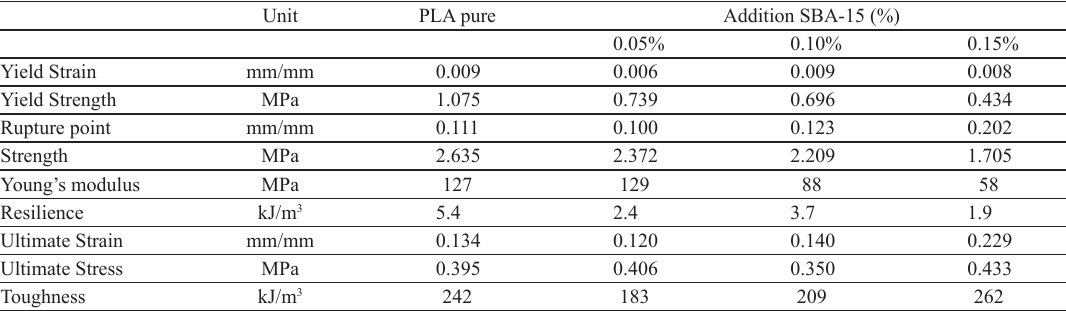
Figure 9. Mechanical properties of the PLA fiber spun mat of 10% and PLA/SBA‑15 fiber composite. (A) Represent the Yield strength, (B) the strength, (C) the resilience, (D) the Young´s Modulus, (E) the rupture point and (F) the Toughness behavior of the fiber spun membranes of PLA concerning the different percentages concentration of the SBA‑15 mesoporous ceramic material. Table 1. Mechanical Properties values obtained from scaffolding at different concentrations of SBA‑15 mesoporous